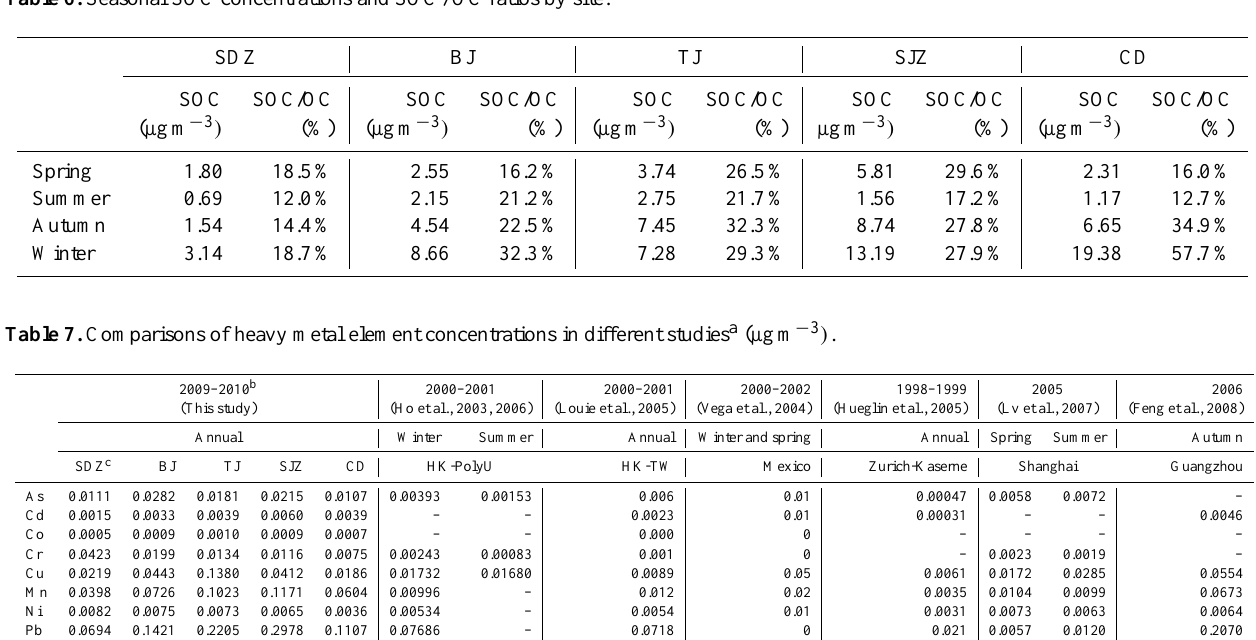
Table 6. Seasonal SOC concentrations and SOC/OC ratios by site.